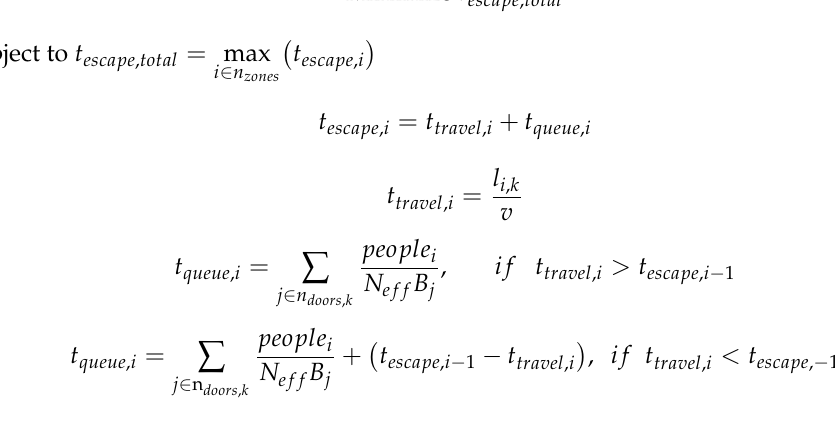
Figure 6. Schematic of the multi-stage fire alarm subsystem.